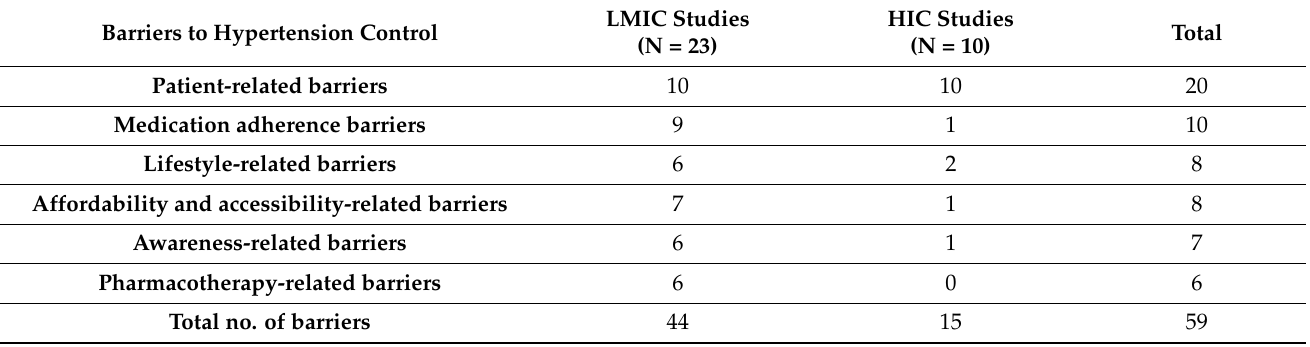
Table 3. Summary of the categories of hypertension control barriers across countries’ income groups and their overall